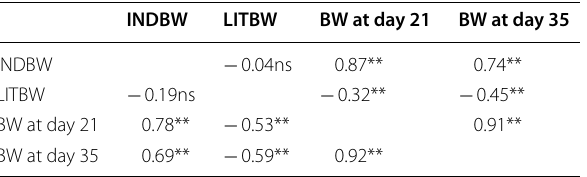
Table 5 Phenotypic and genotypic correlations of body weight for all crossbred